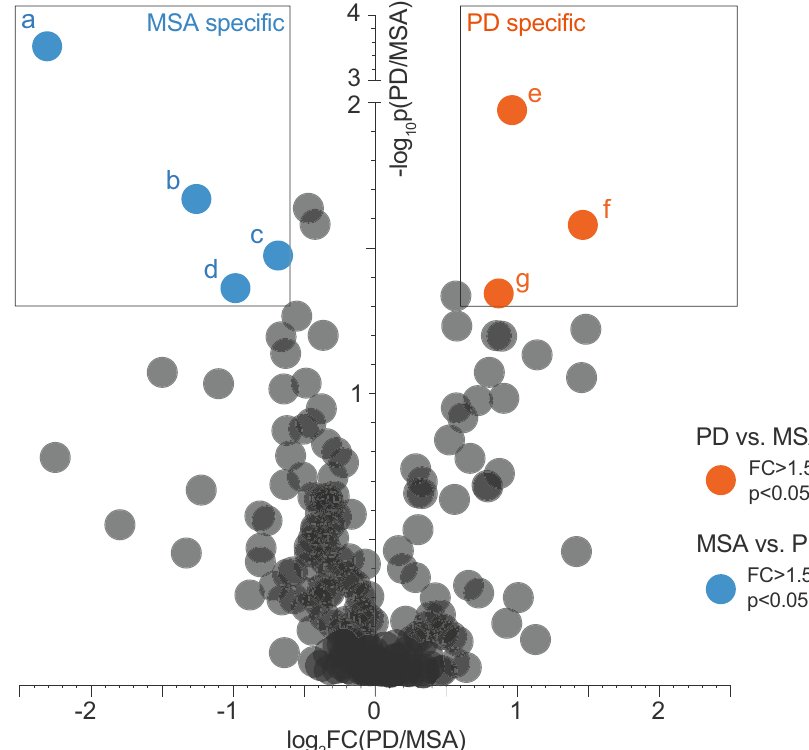
Fig. 4 The remarkable overlap between PD and MSA respective insoluble proteomes. The bubble chart represents mass spectrometry analysis of the 206 proteins gated in Fig. 2 that are signi fi cantly enriched in PD or MSA compared to control Sarkospin pellets. Each protein is positioned upon the fold change (log 2 FC) of its enrichment in PD insoluble pellets compared to MSA, and the statistical signi fi cance of the protein abundance difference between PD and MSA Sarkospin pellets ( − log 10 p ). Color-coding corresponds to each protein ’ s gating: red: n = 3 proteins signi fi cantly enriched in PD and blue: n = 4 proteins signi fi cantly enriched in MSA pellets as opposed to the other disease group respectively, and black: n = 199 proteins not signi fi cantly different between PD and MSA. Signi fi cantly enriched terms a FC > 1.5 with p < 0.05 with n = 3 independent biological samples per group. a Protein phosphatase methylesterase 1; b vesicle-fusing ATPase; c calnexin; d phospholipid-transporting ATPase IA; e collagen alpha-1(XVIII) chain; f 39S ribosomal protein L47, mitochondrial; g receptor expression- enhancing protein